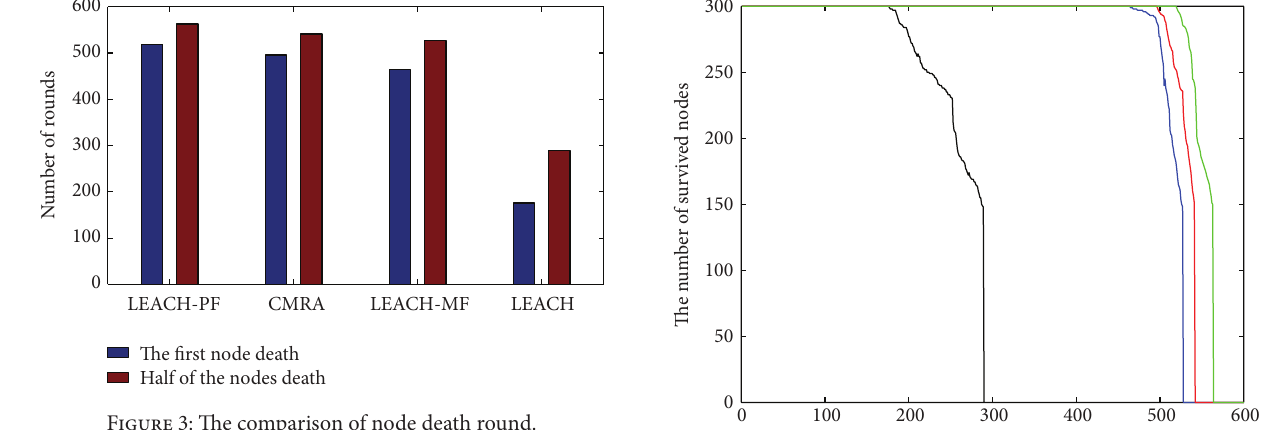
Figure 3: The comparison of node death round.